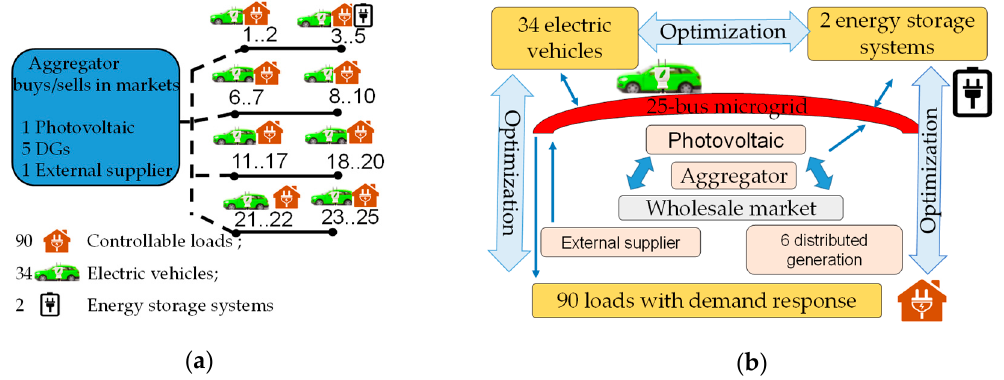
Figure 1. Description of the energy management problem: ( a ) Real-world; ( b ) Artificial problem.